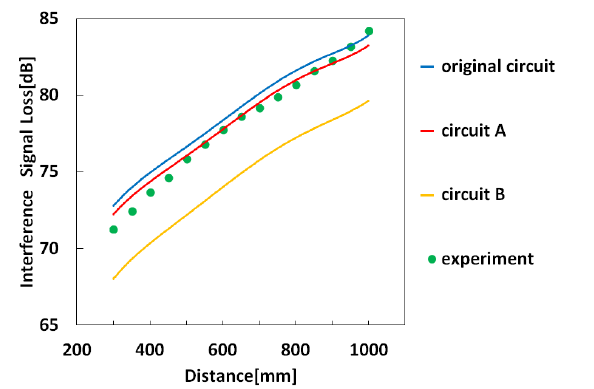
Figure 13. Interference signal loss according to distance between phantom 1 and